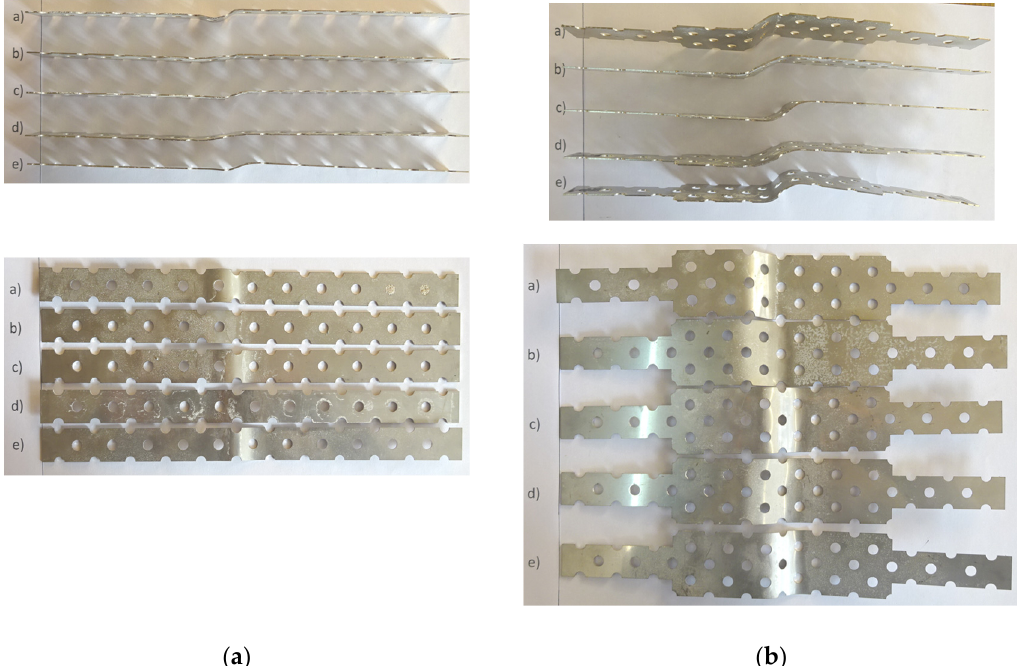
Figure 8. Deformed connectors removed from damaged test models after tests: ( a ) punched flat profiles in the wall B10_2, ( b ) punched widened flat profiles in the wall Table 8. Measured geometry of deformed connectors.